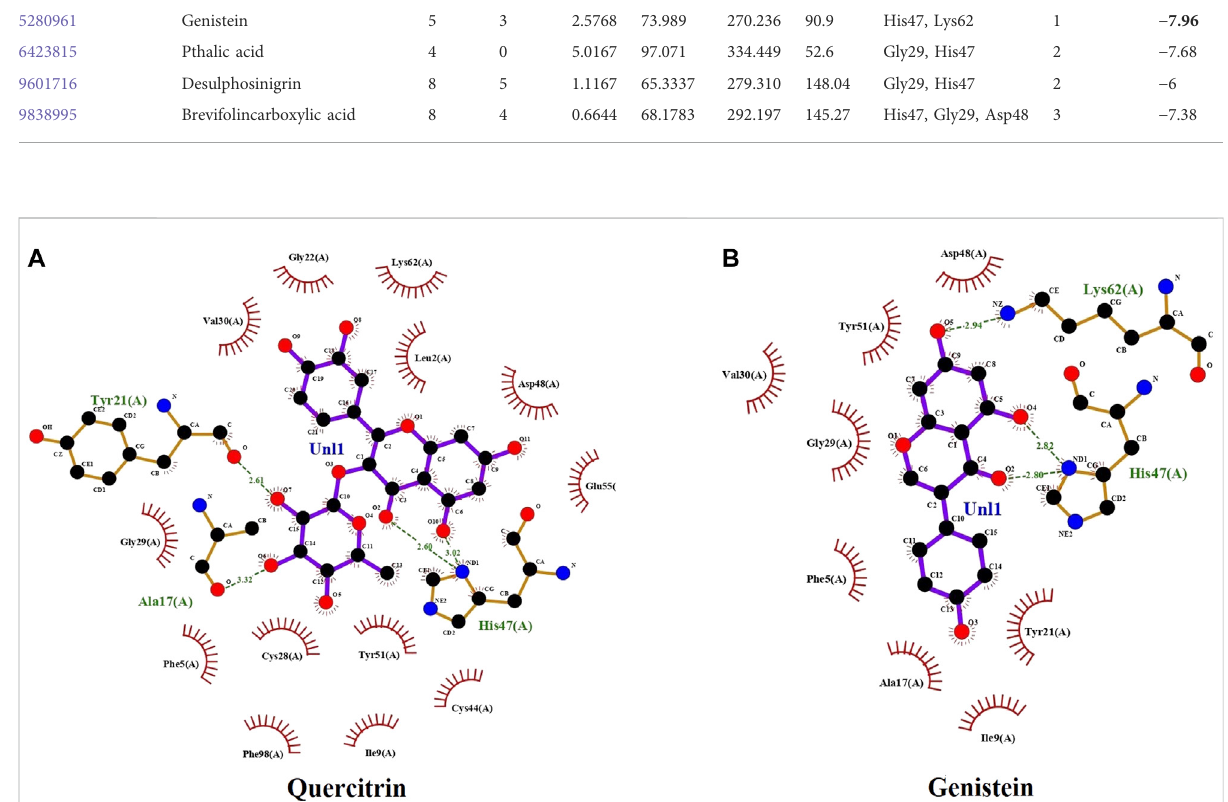
FIGURE 1 The docking study: docked images of quercitrin (A) and genistein (B) with sPLA 2 IIa enzyme